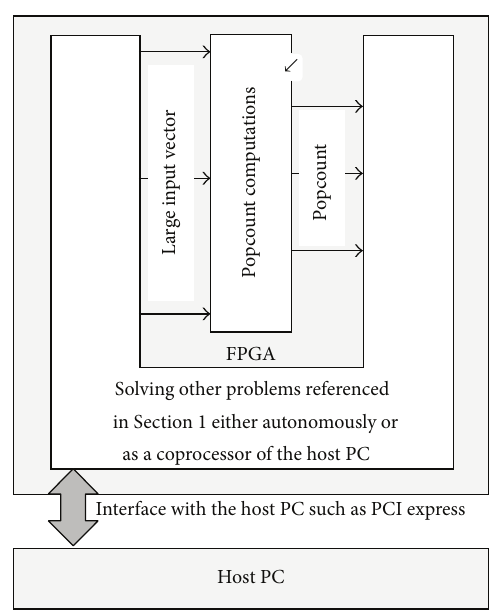
Figure 1: FPGA-based accelerator for a general-purpose computer.